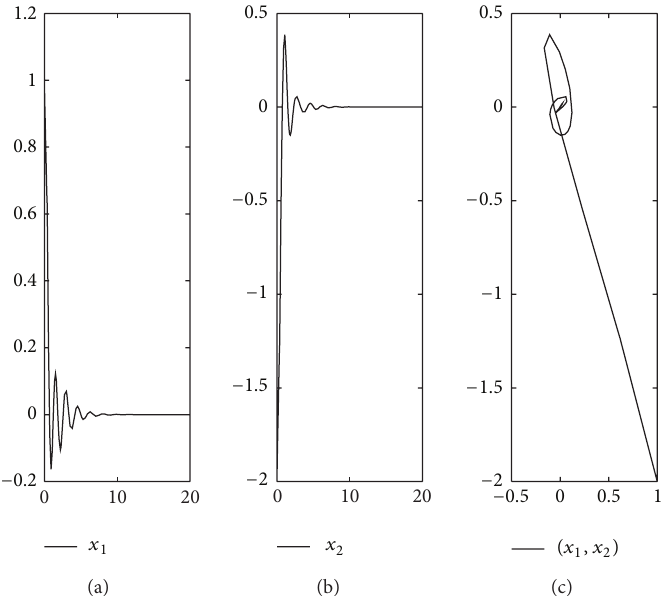
Figure 1: For system (1), the equilibrium (0, 0) is asymptotically stable when 𝜏 = 0.55 < 𝜏 0 ≈ 0.6378 .